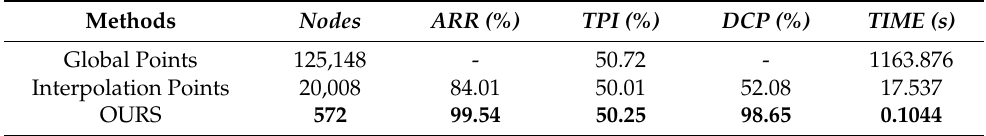
Table 4. The metrics of different intervisibility analysis methods.